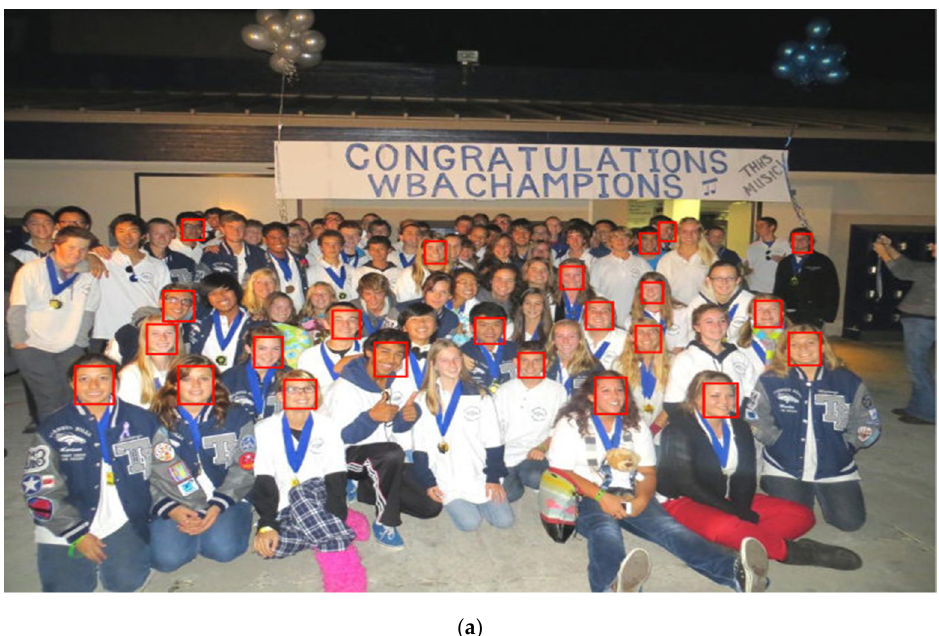
Figure 6. The precision–recall (PR) curve of f-R-FCN and R-FCN on Wider Face.